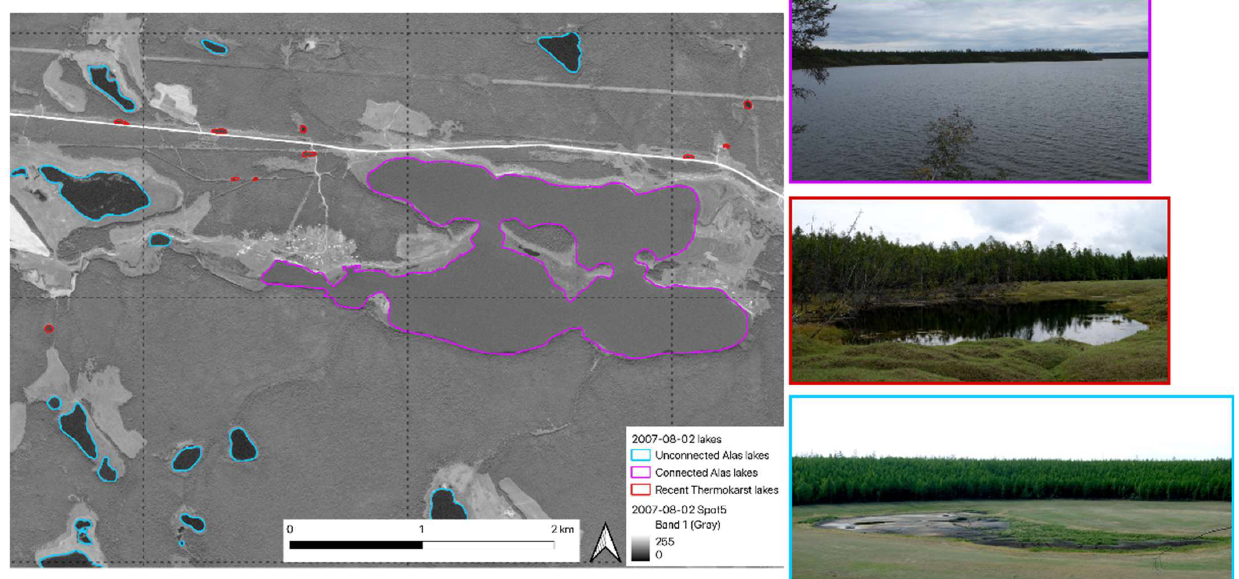
Figure 2. Distribution of lake types in a subset of the center study area: unconnected alas lakes (clear blue), connected alas lakes (magenta), and recent thermokarst lakes (red) are outlined on the 2013-07-14 Spot image. Pictures of each lake type are shown on the right, outlined in the representative colors.